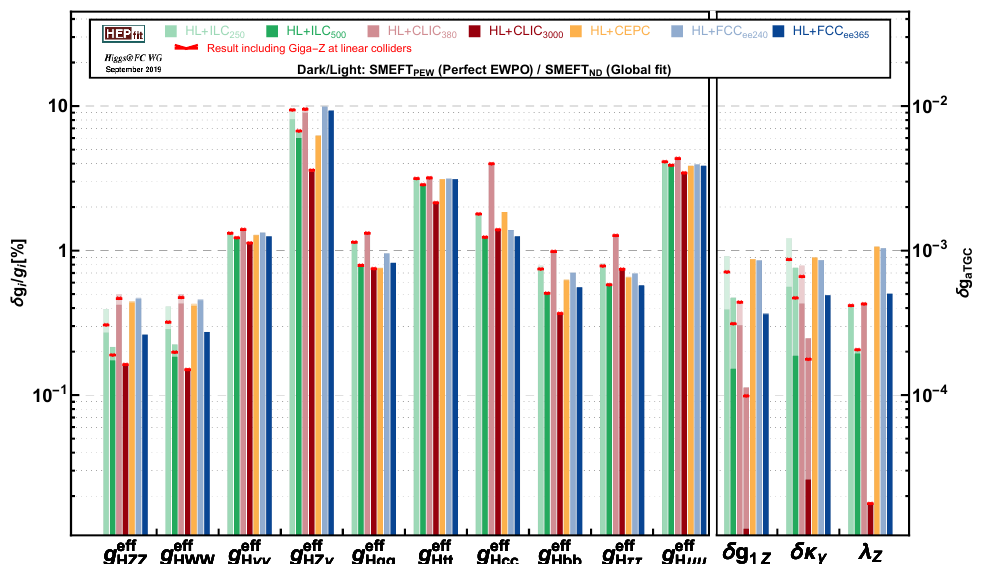
Figure 5 . 68% probability reach on Higgs couplings and aTGC values for the di(cid:11)erent lepton colliders from the Global (cid:12)t SMEFT ND , compared with the results obtained assuming in(cid:12)nite precision for the EWPO (scenario SMEFT PEW ). The di(cid:11)erence (partially) illustrates the impact of the EW constraints on the Higgs results. See text for discussion and caveats which apply to this study. The measurements based on Z bosons from radiative return at ILC and CLIC are included in the default (cid:12)t, and the horizontal red marks indicate the coupling reach when additionally a dedicated Z -pole run is